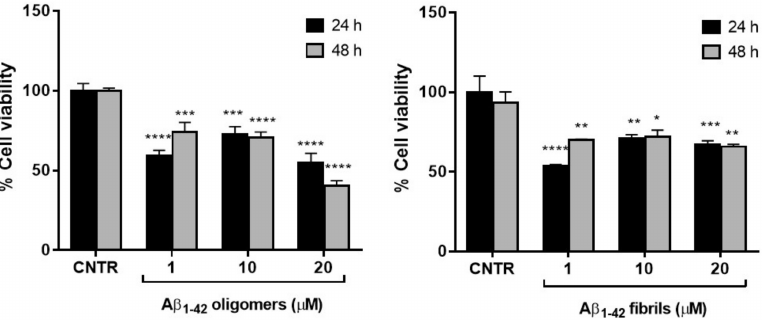
Figure 2. Cell viability after exposure to A β . NHA cells were incubated with different doses of A β oligomers ( a ) or fibrils ( b ) ranging from 1 to 20 µ M, for 24 or 48 h. The cytotoxicity of treatments was assessed by MTT assay; * p < 0.05; ** p < 0.01; *** p < 0.001; and **** p < 0.0001 (two-way